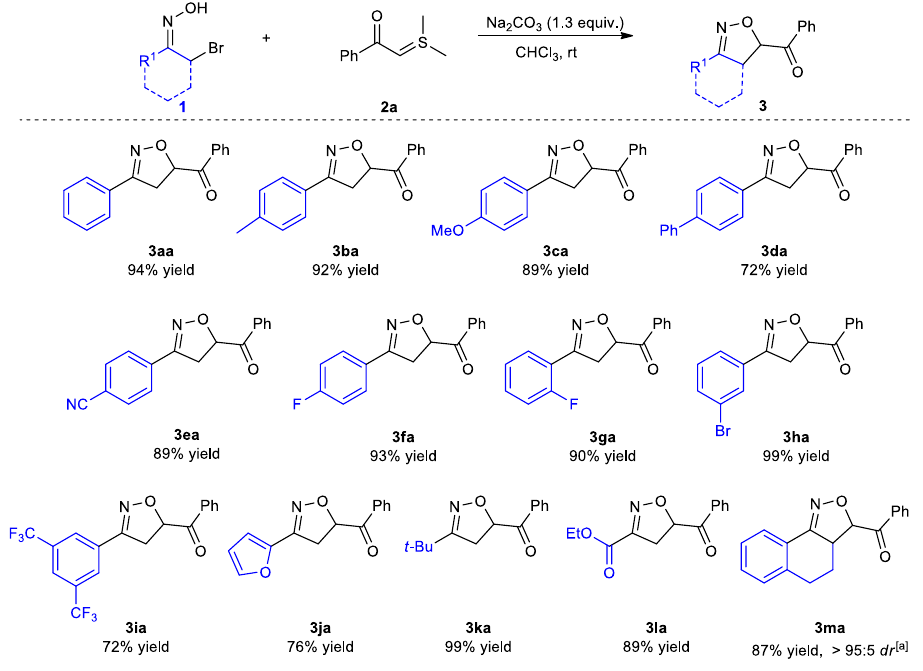
Figure 2. [4 + 1] annulation of various α-bromooximes 1 with sulfur ylide